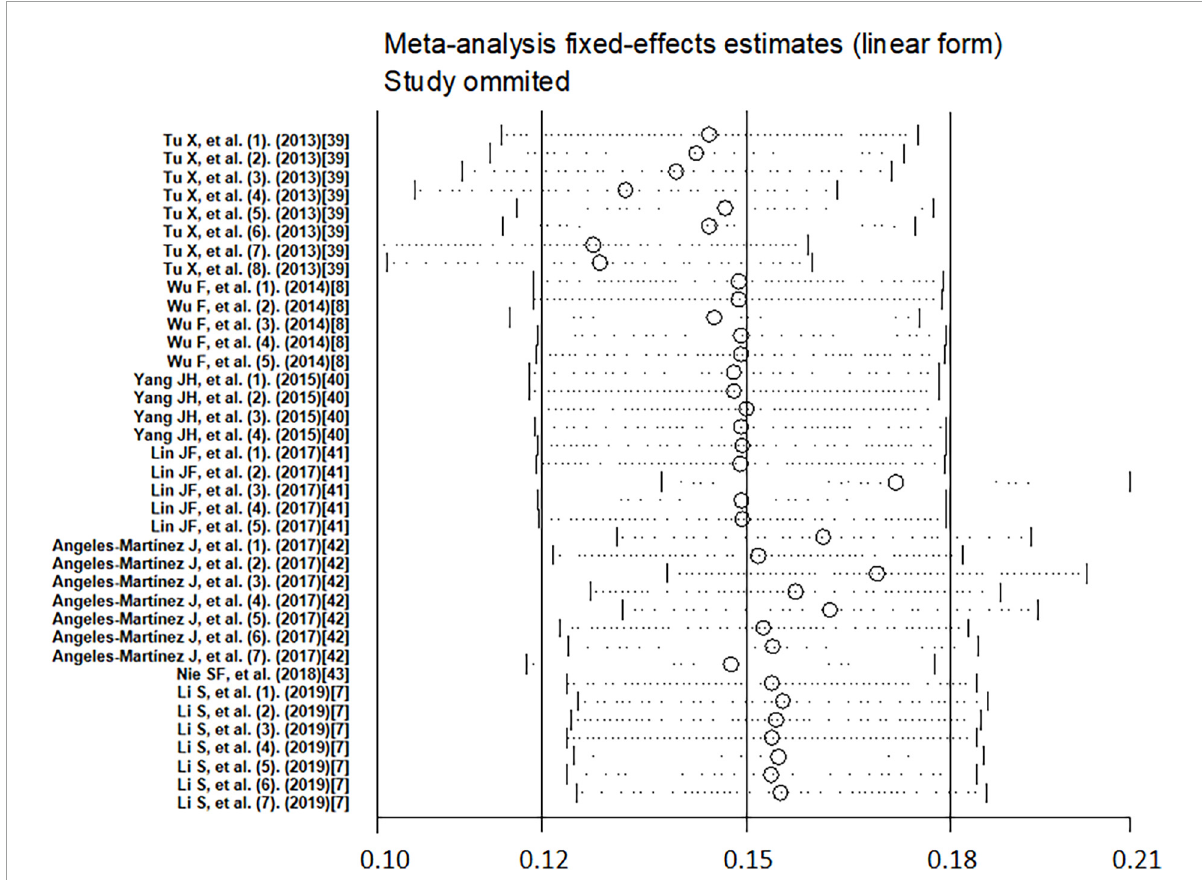
FIGURE6 Meta-analysis of the relationship between IL-33/ST2 and coronary artery diseases risk OR, odds ratio; CI, confidence